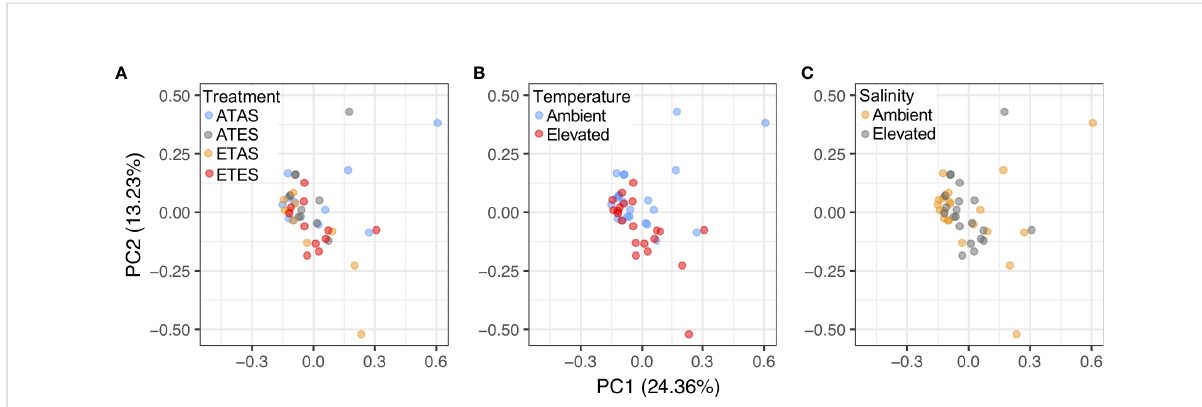
FIGURE 2 Principal components analysis biplots showing the similarity in composition of volatile compounds in blue swimmer crab ( Portunus armatus ) meat following experimentation (A) among all treatments, and between levels within the (B) temperature, and (C) salinity treatments. ATAS, ambient temperature and salinity; ATES, ambient temperature and elevated salinity; ETAS, elevated temperature and ambient salinity; and ETES, elevated temperature and